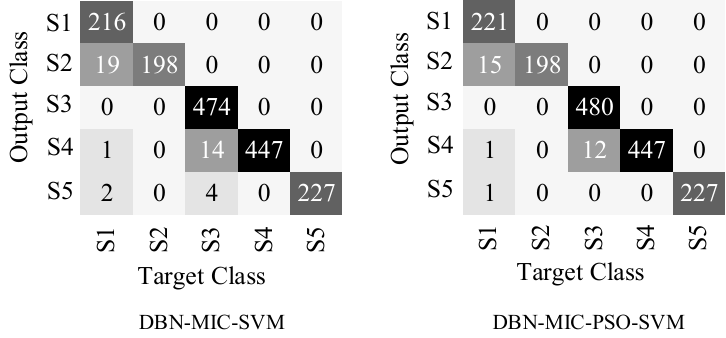
Figure 13. Confusion matrices comparison of the SVM classification algorithm, before and after the PSO.